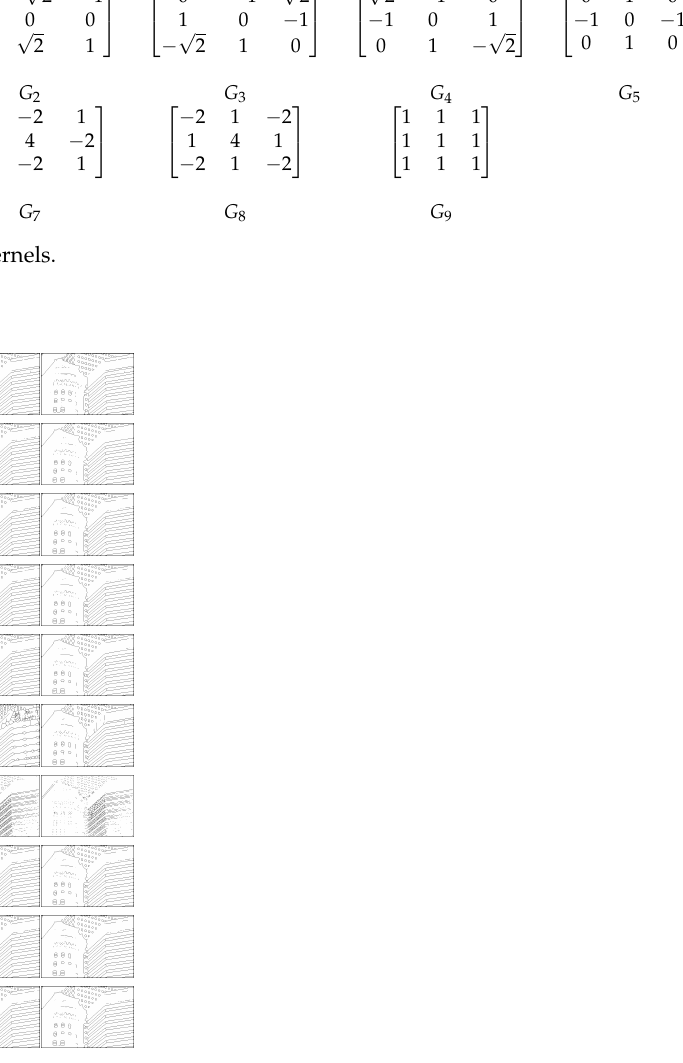
Figure A8. First-order derivative orthogonal gradient operator results. Columns: Original, 3 × 3, Dilated 5 × 5 and Dilated 7 × 7. Rows: Pixel Differences, Separated Pixel Difference, Sobel, Prewitt, Kirsch, Kitchen, Kayyali, Scharr, Kroon and Orhei.